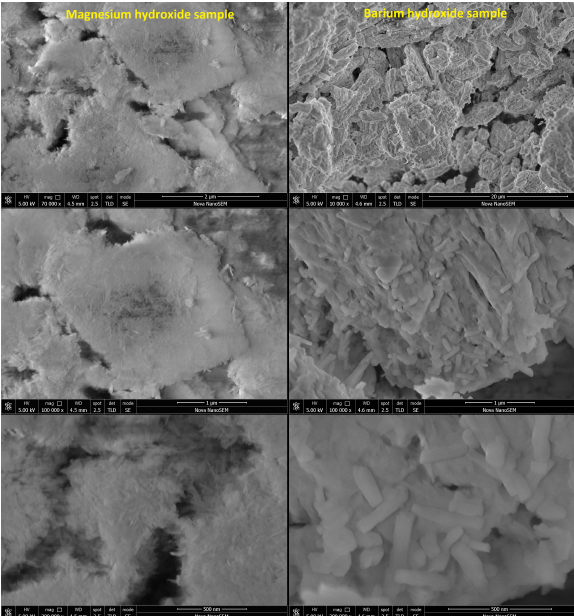
Figure 3. SEM images of product powders. Left column: Mg(OH)